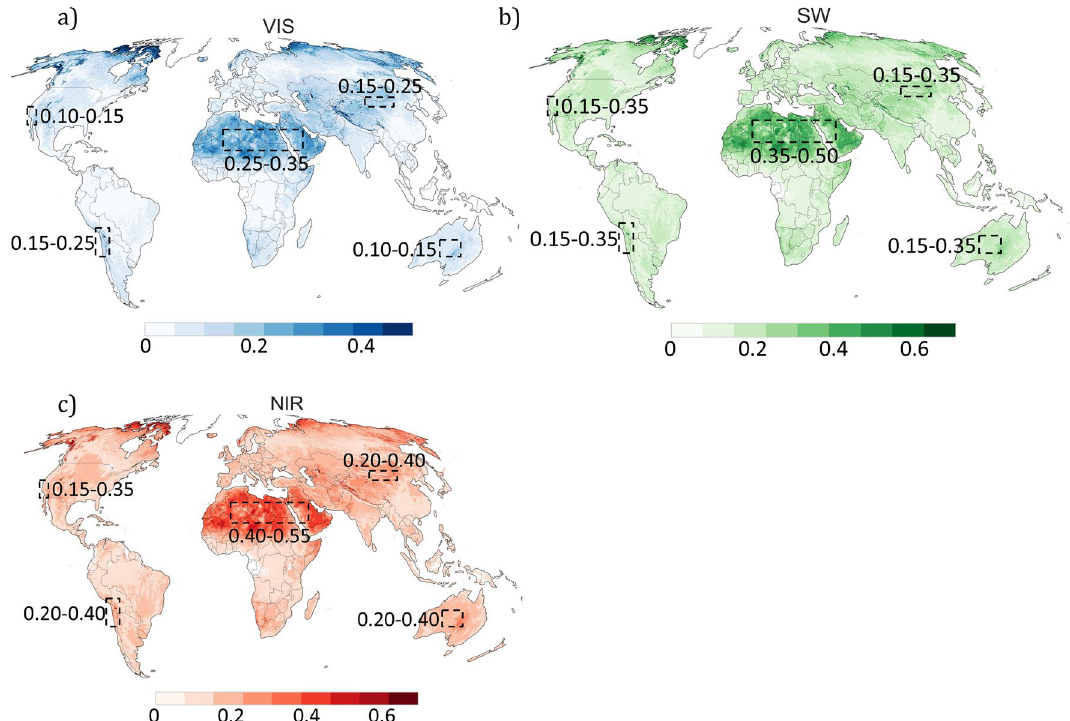
Figure 5. Satellite-derived estimates of the white-sky albedo averaged over the period 2011–2020 for the following broadbands: ( a ) Visible (VIS), ( b ) Shortwave (SW), and ( c ) Near infrared (NIR). Plots were generated using Python’s Matplotlib library 44 with data from the Moderate Resolution Imaging Spectroradiometer (MODIS) MCD43A3 Version 6 Albedo Model dataset 24